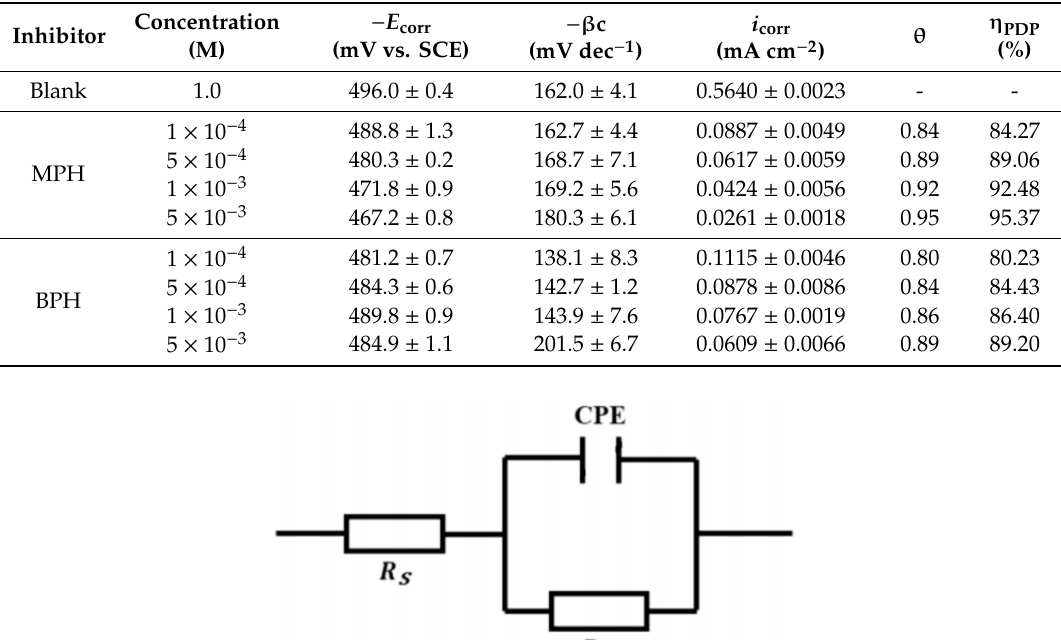
Table 7. Electrochemical parameter values estimated according to electrochemical impedance spectroscopy curves of MS in HCl solution in the presence and absence of several concentrations of MPH and BPH at 303 K.